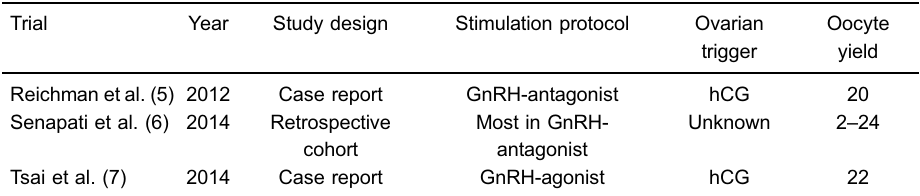
Table 2. Studies on the preservation of fertility in patients with myelodysplastic syndrome through oocyte/ embryo